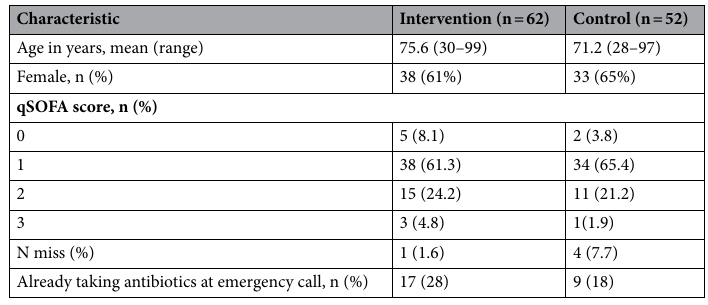
Table 1. Baseline